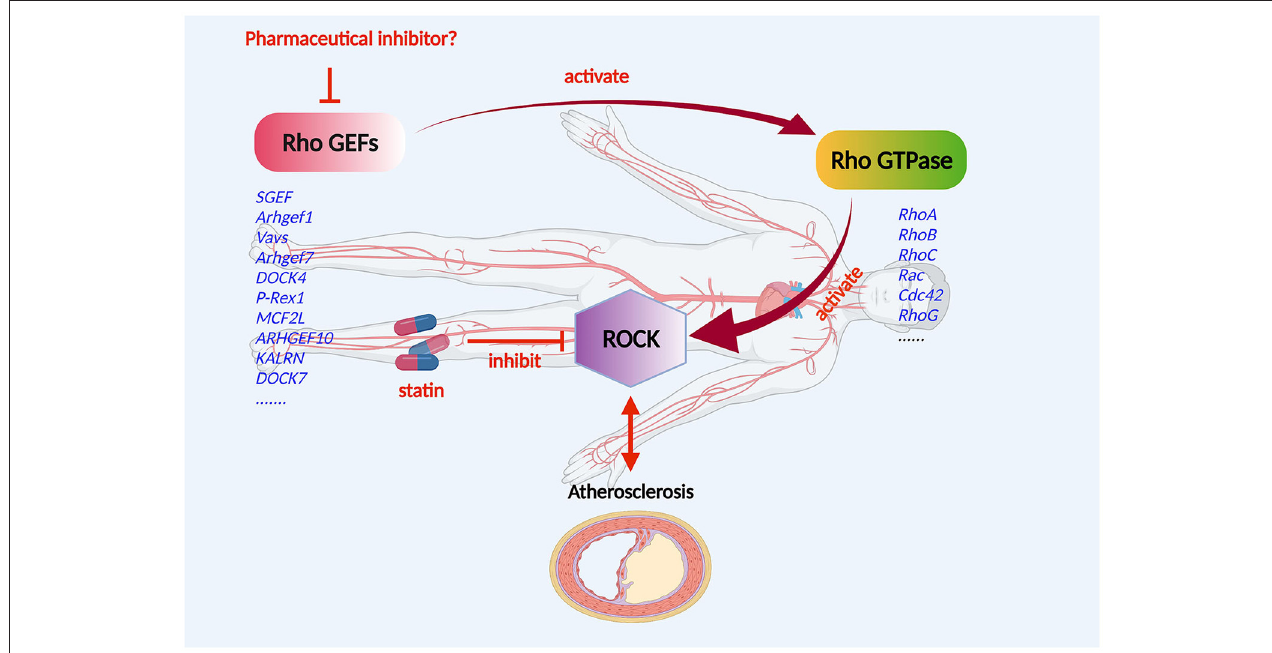
FIGURE 3 | Mechanism of Rho GEF regulation of atherosclerosis. Rho GEF proteins may be involved in the occurrence and progression of atherosclerosis, and the composition of atherosclerotic arteries including the endothelium, smooth muscle, and macrophages. The Rho GEF/Rho GTPase/ROCK signaling pathway plays an important role in the development of atherosclerotic disease. Rho GEFs, as activators and the most direct upstream molecules of Rho proteins, are expressed in cardiovascular cells and are suitable candidate targets for the drug therapy of atherosclerotic disorders.